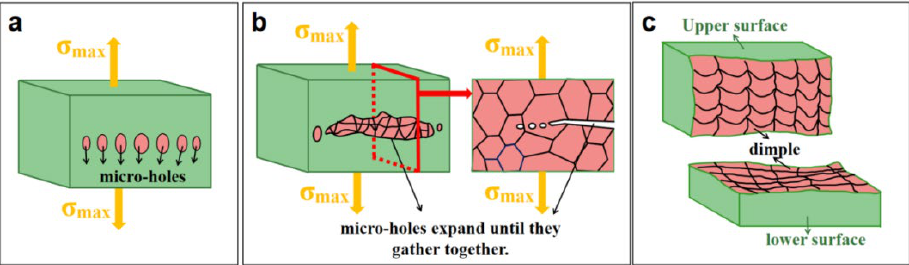
Figure 17. Instantaneous fracture of fatigue coupon: ( a ) micro-holes; ( b ) micro-holes expand and aggregate; ( c ) fracture .